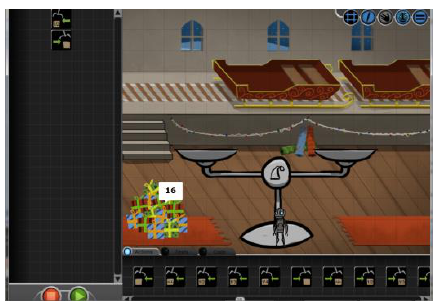
Figure 3. Visual hints in the Santa Claus exercise provided context and helped learners identify the optimal divide-and-conquer